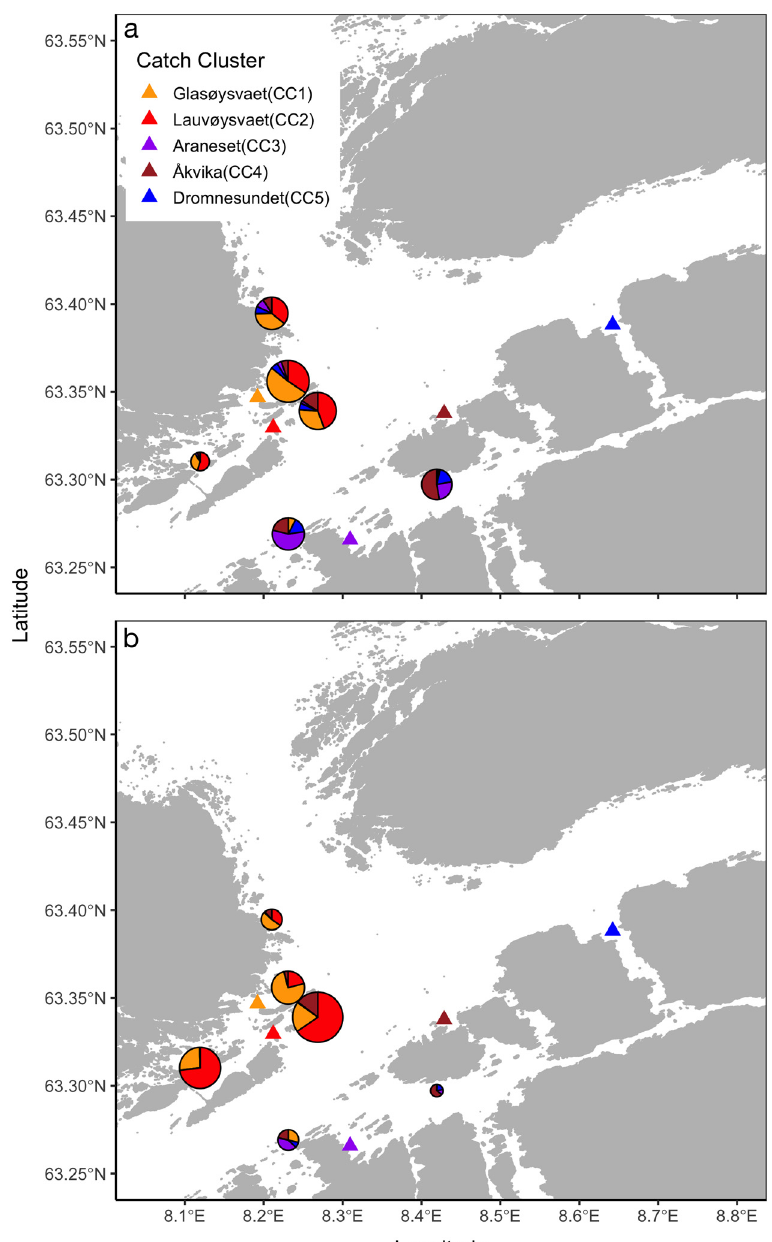
Fig. 6. Origins of cod detected at a salmon farm based (a) the number of fish detected or (b) the number of detections. Sizes of pie charts are scaled to the numbers at the different stations. Triangles: averaged release point positions for each catch cluster (CC) in